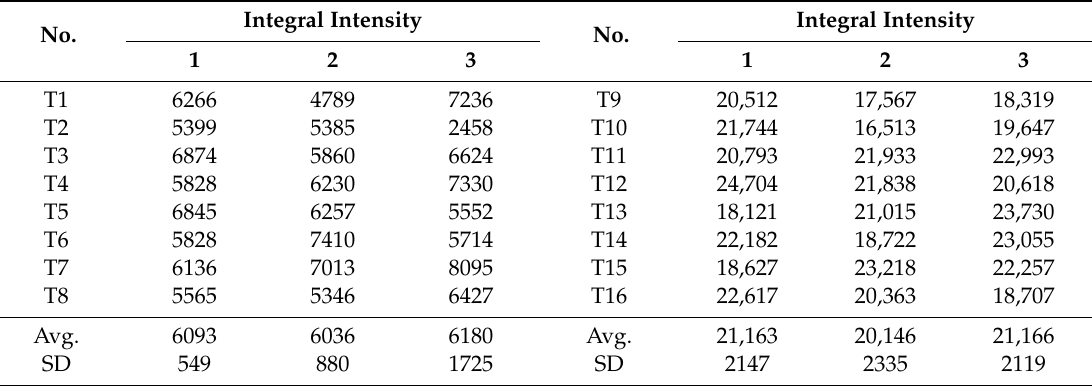
Table 1. Integral intensities of asbestos peaks for standard talc samples with di ff erent ACM concentrations (1% and 3%).